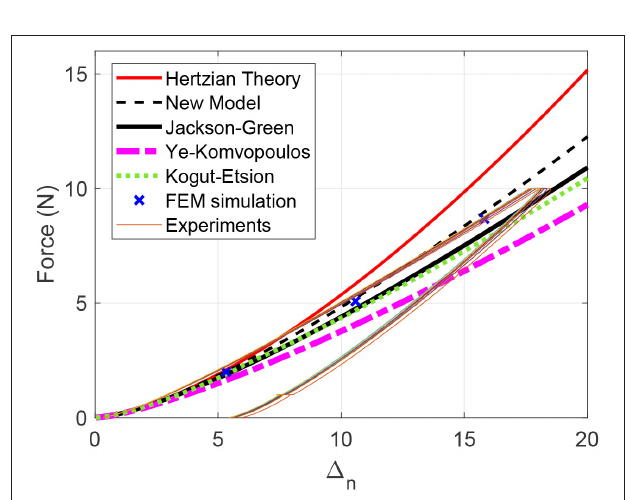
FIGURE 15 | Comparison between the new model and experimental data from Brake et al. (2017) for Stainless Steel 304.